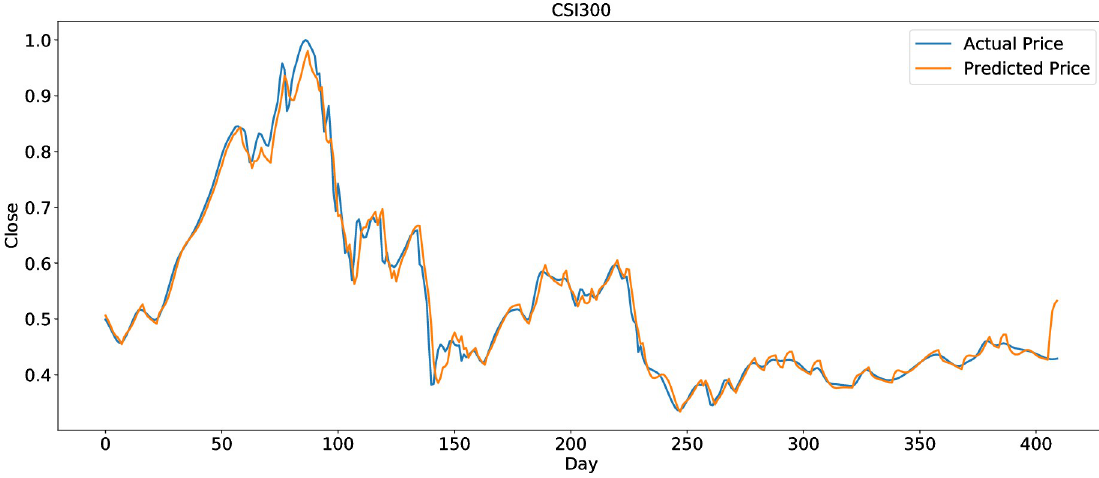
Fig 16. Prediction results of CSI300 data